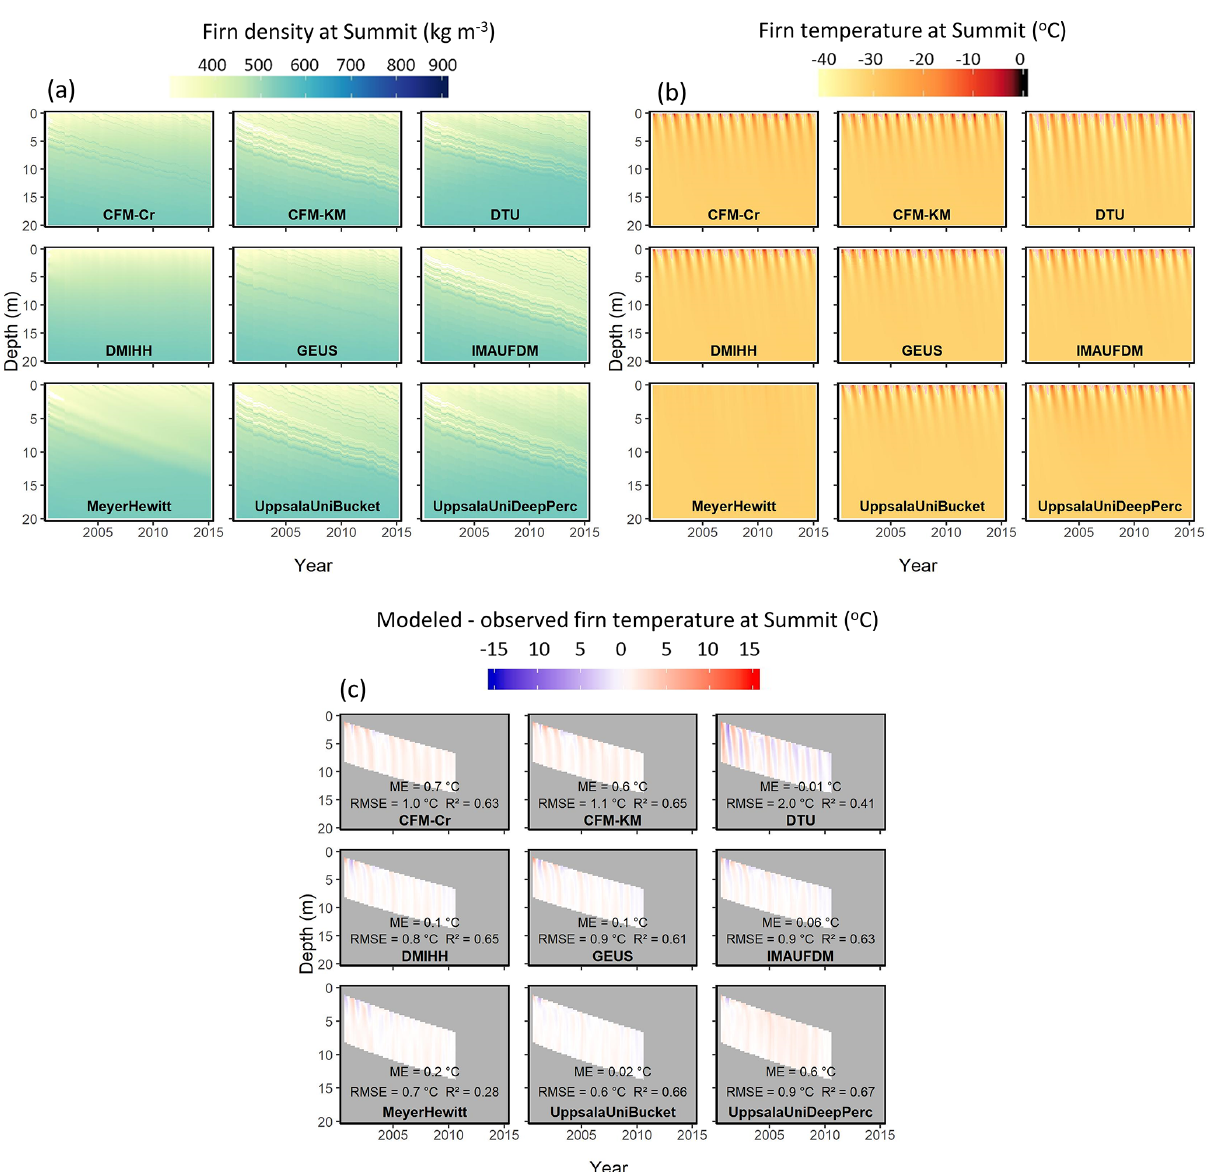
Figure 2. Simulated firn density (a) , temperature (b) and deviation between simulated and observed firn temperature (c) at